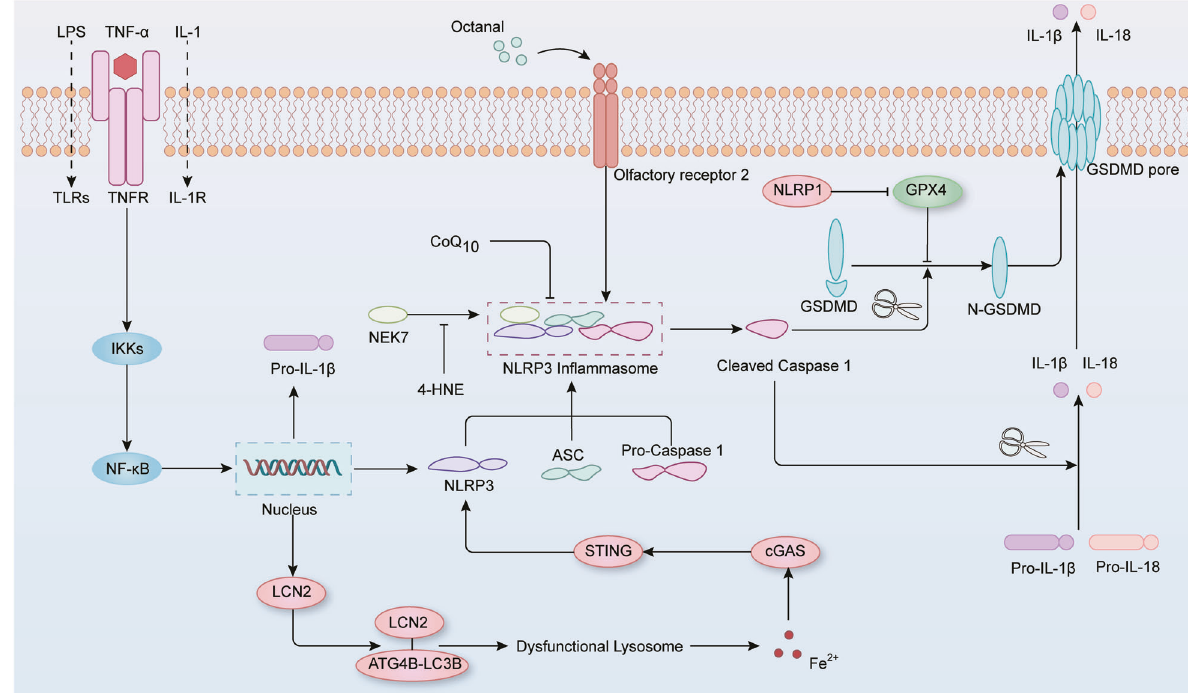
Fig. 5 The role of in fl ammasome signaling pathway in ferroptosis. Membrane receptors sense in fl ammatory signals and, in turn, activate the NF- κ B signaling pathway to induce NLRP3 and IL-1 β transcription. NLRP3 recruits ASC and pro-caspase 1 to trigger the assembly of the NLRP3 in fl ammasome, which mediates the self-cleavage of pro-caspase 1. Activated caspase 1 further cleaves pro-IL-1 β and pro-IL-18, which leads to the maturation of these proin fl ammatory cytokines. In parallel, gasdermin D is cleaved by caspase 1, and its N-terminal domain